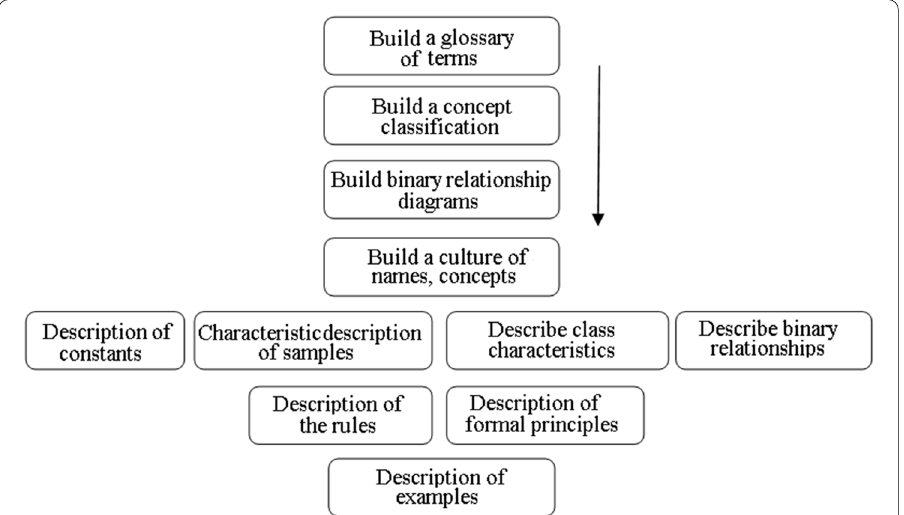
Fig. 2 Eleven stages of ontology engineering based on methontology